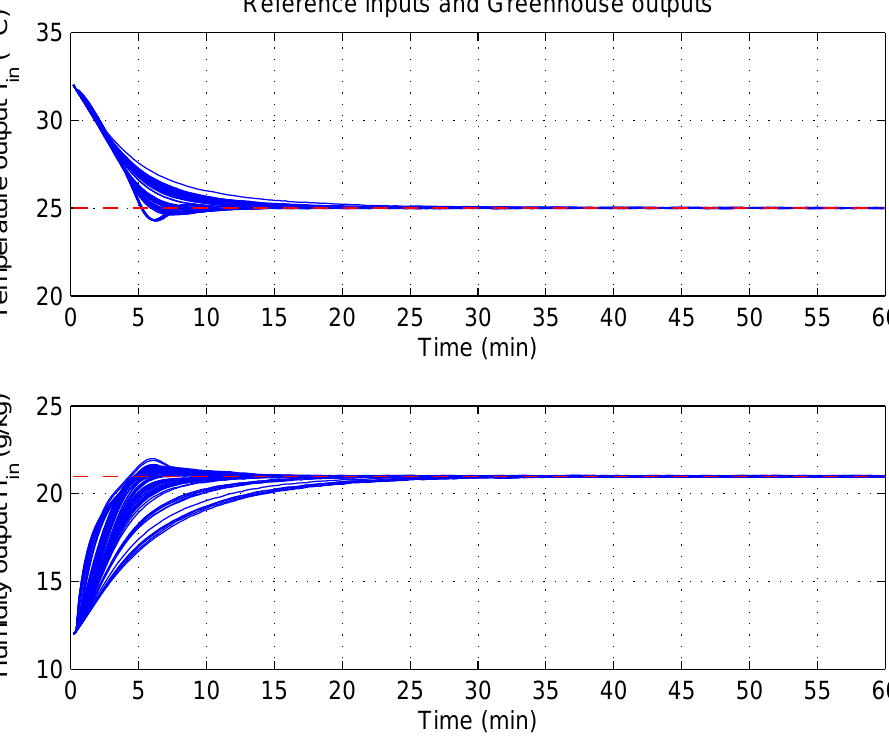
Figure 5. Step responses with PID control at each